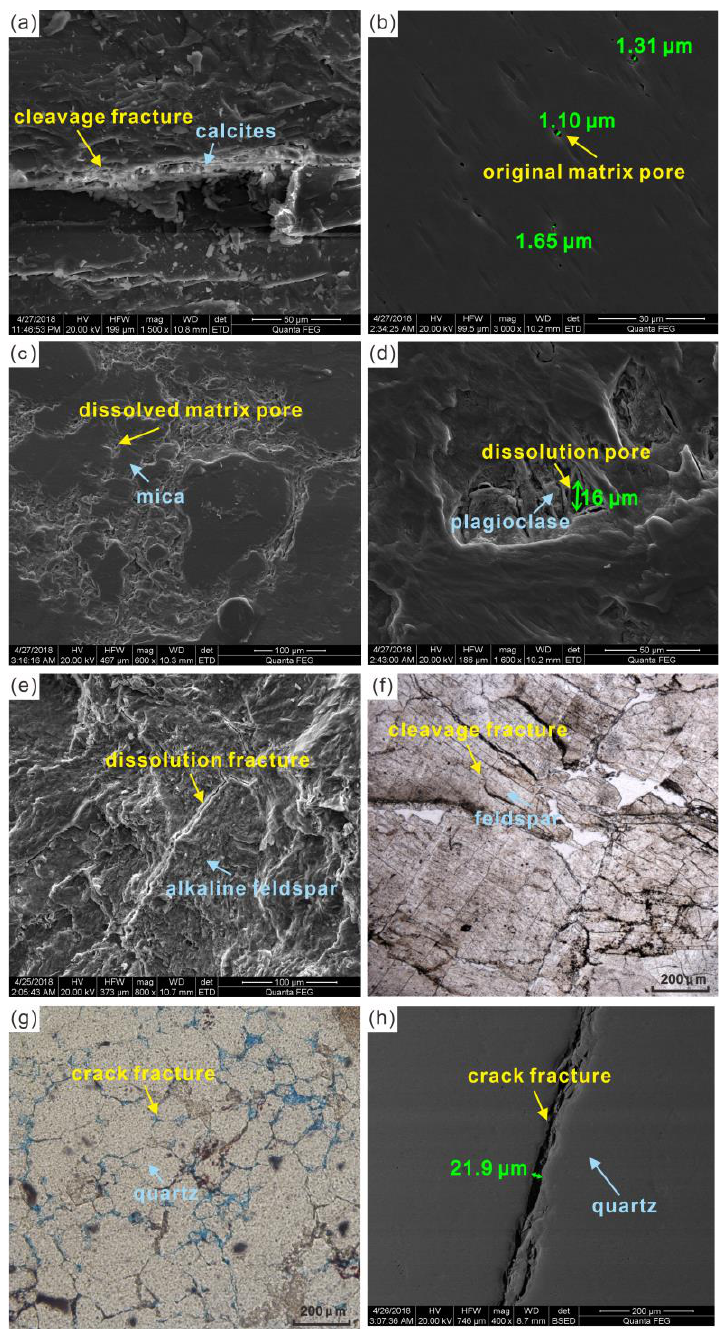
Figure 9. Reservoir characterization regarding different layers of weathering crust. ( a ) Cleavage fracture that is filled with calcites, Nb1, 3640.35 m; ( b ) Original matrix pores formed in quartz, Nb1, 3643.25 m; ( c ) Dissolved matrix pores formed with the mica carbonization, Dp103, 3230 m; ( d ) Dissolution pores in plagioclase, N4, 998.2 m; ( e ) Dissolution fractures formed in alkaline feldspars, DP7, 2170.6 m; ( f ) Cleavage fractures formed in the inner region of feldspars, Nb1, 3742 m; ( g ) Crack fractures that connect the intergranular pores in the margin of quartz, Jb1, 4647.95 m. ( h ) Crack fracture that cuts through the quartz, Dp123, 3360